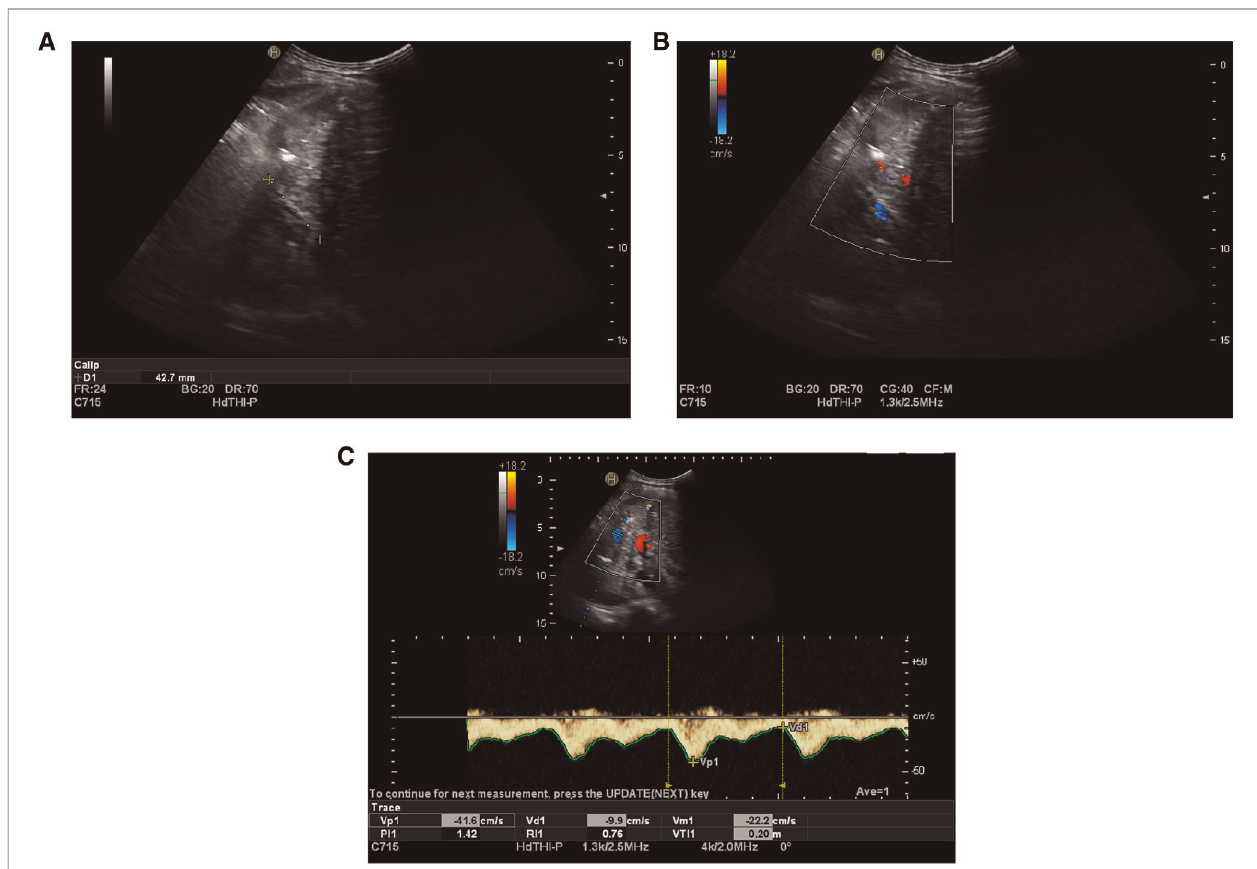
FIGURE 3 | ( A ) Arti fi cial vessels, which were visualized by ultrasound one week after operation, were approximately 42.7 mm in length. ( B ) Blood fl ow of arti fi cial blood vessels displayed by ultrasound one week after operation (blue). ( C ) Ultrasound blood fl ow spectrogram of arti fi cial vessels one week after operation, showing blood fl ow